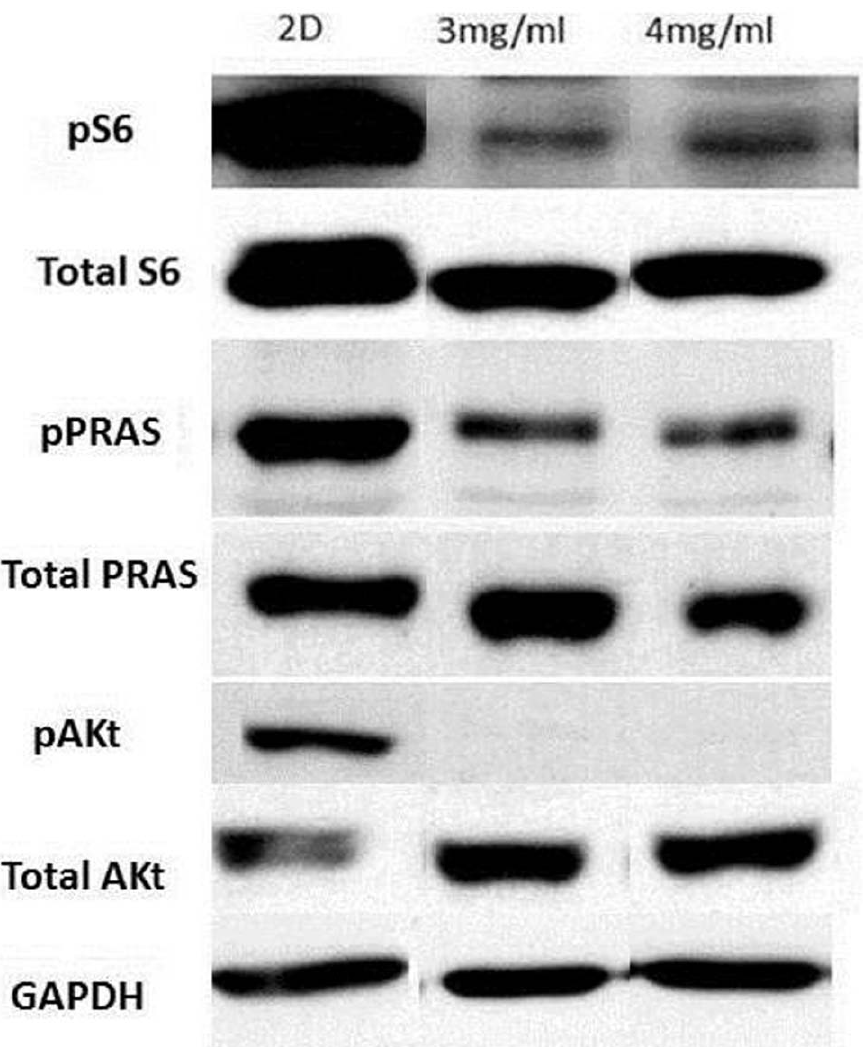
Figure 7. Protein expression blots from U20S cells grown on tissue culture plastic or in 3D collagen gels. Cells were plated, and then harvested 24 hours later. Cell lysates were kept at 2 80 u C if not immediately used. Cells in 3D had undetectable amount of pAkt, indicating a low level of overall pathway activity. This is consistent with the reduction in cell proliferation seen in earlier experiments.